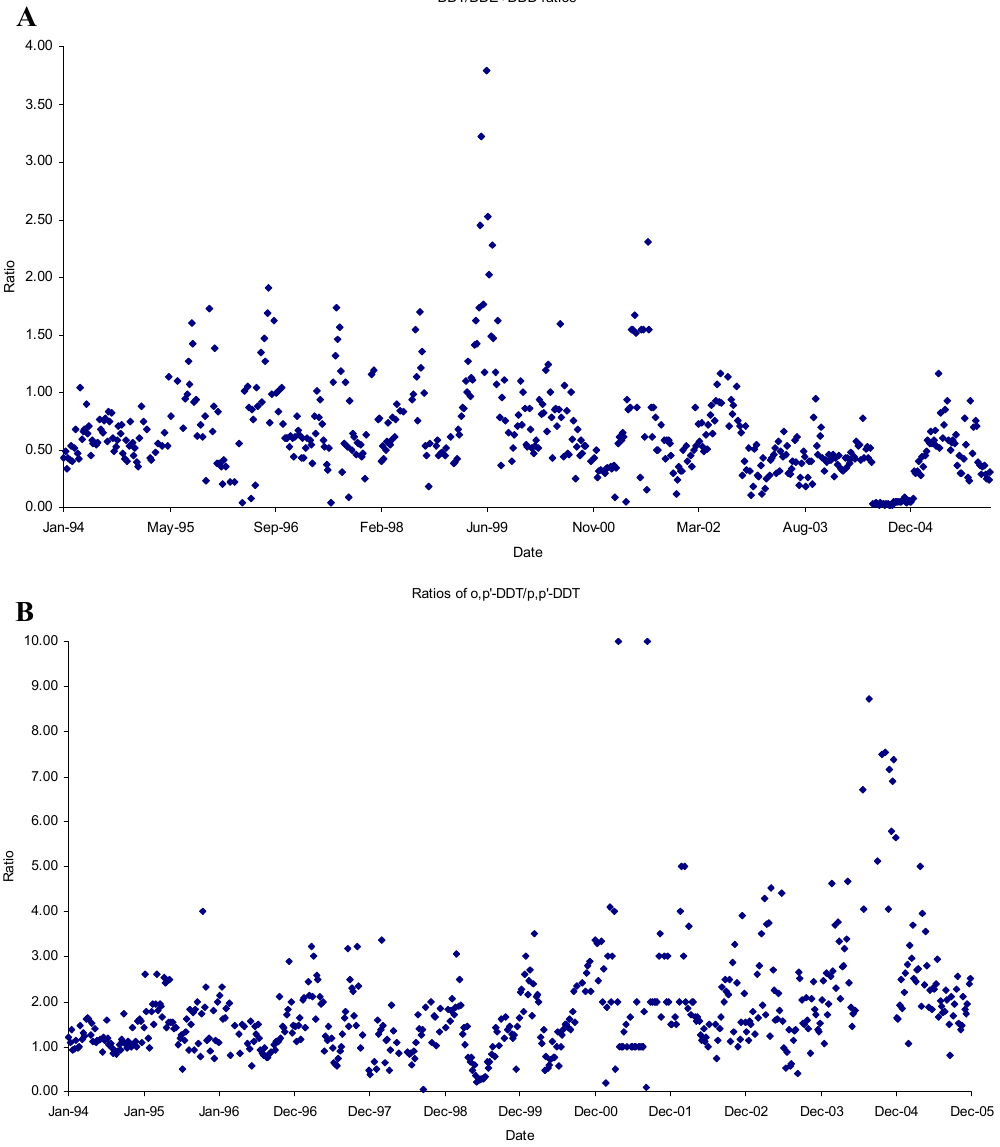
Figure 4: Ratios of DDT/DDE+DDD ( A ) to illustrate the age of the DDT signal, and o,p’ -DDT/ p,p’ -DDT ( B ) to indicate whether sources are from Dicofol or Technical-DDT DDT/DDE+DDD ratios